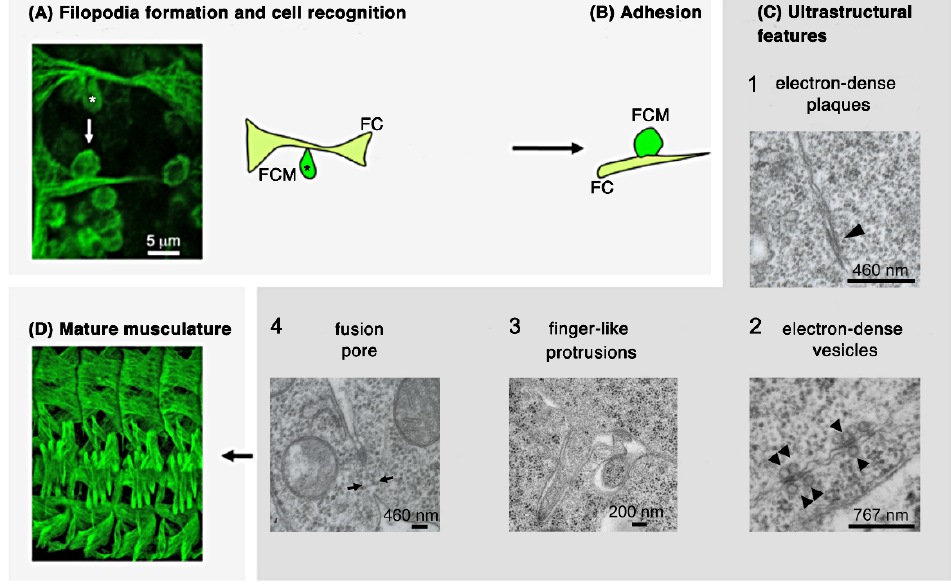
Figure 2. Scheme representing the cellular sequences of Drosophila myoblast fusion in the embryo. ( A ) Fusion-competent myoblasts (FCM; dark green) orient their filopodia towards the founder cell to which they attach (FC/growing myotube; light green). ( B ) Founder cells and fusion-competent cells align and come into close contact. ( C ) Electron microscopy studies revealed additional steps of myoblast fusion: (1) electron-dense plaques and, (2) vesicles, (3) formation of finger-like protrusions, and (4) fusion pores. The numbering (1) to (3) does not necessarily reflect the temporal appearance of these structures. ( D ) This leads finally to the formation of the larval multinucleated bodywall musculature.